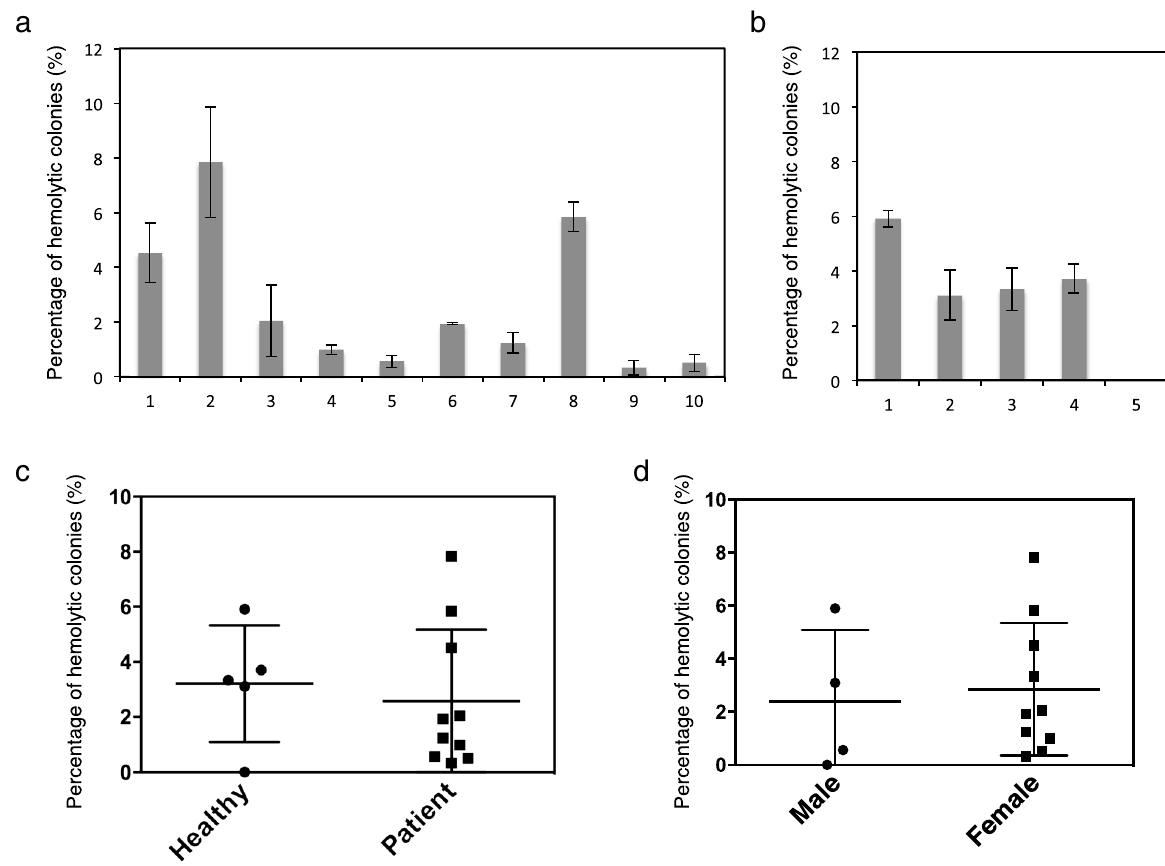
Figure 1. Measurement of hemolytic bacteria in human saliva. (a,b) Percentages of hemolytic bacterial cells in saliva from periodontal disease patients (a) or healthy subjects (b) . Individual saliva samples (n = 3) were spread on agar plates containing horse blood and incubated at 37 °C under anaerobic conditions. The numbers of hemolytic and non-hemolytic bacterial colonies were determined using the plate count technique. Error bars show the mean ± standard deviation (SD) values. (c) No significant differences in the percentage of hemolytic bacteria were observed between healthy subjects (black circles) and periodontal disease patients (black squares). Mann–Whitney U-test. Error bars show the mean ± standard error of mean (SEM) values. (d) No significant differences in the percentage of hemolytic bacteria in saliva were observed between male and female subjects. Mann–Whitney U-test. Error bars show the mean ±